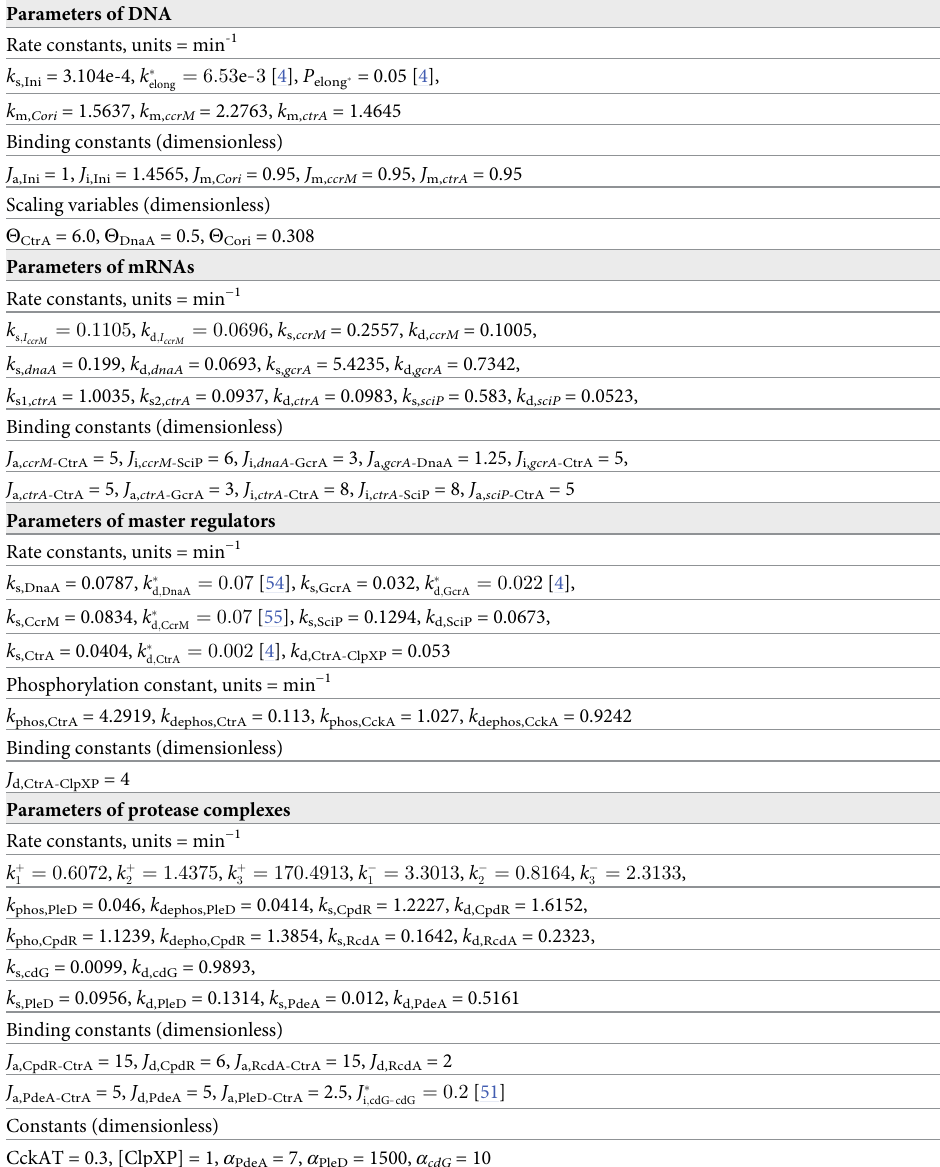
Table 3. Parameter values. Parameters marked with � are obtained from